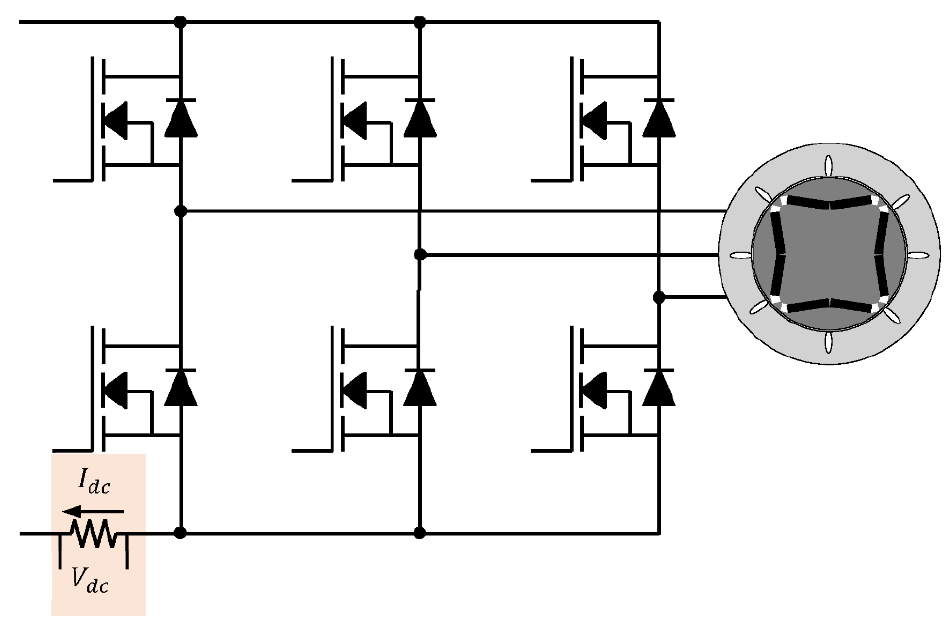
Figure 3. Current measurement method using shunt; Single-shunt resistor inverter.